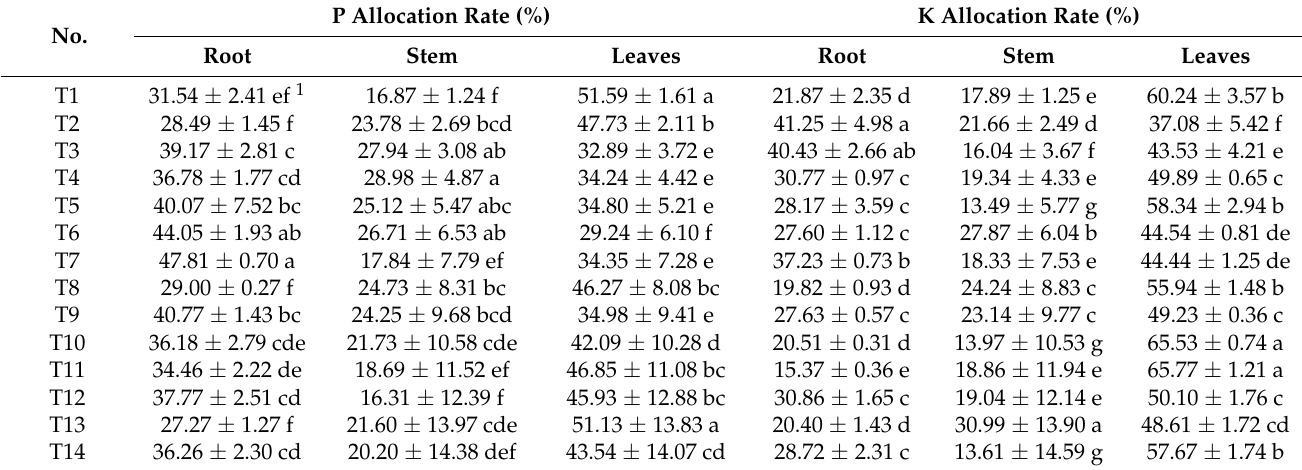
Table 6. P and K allocation rate of P. bournei seedlings under different N-P-K fertilization.